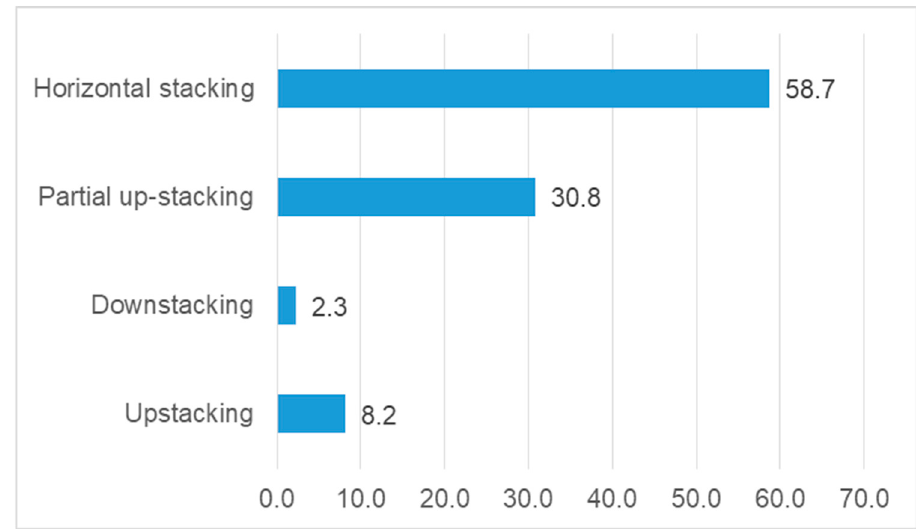
Figure 2. Graph showing the proportion of households using different fuel stacking levels.